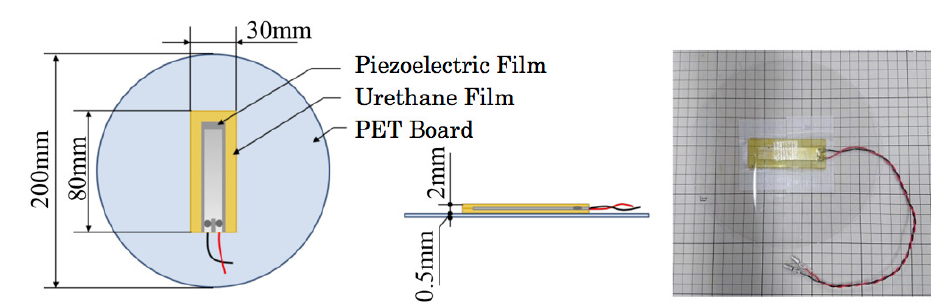
Figure 2. Interior architecture and pad sensor appearance.